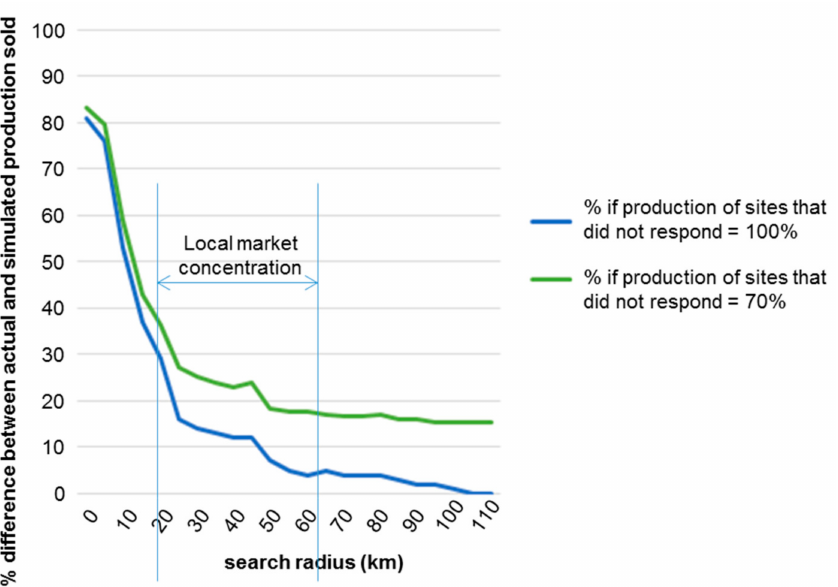
Figure 5. Sensitivity analysis and validation: effect of variation of the search radius and the produc- tion rate of sites that did not respond to the 2015 survey, on the difference between actual global production (2015) and simulated production of materials. Source: this